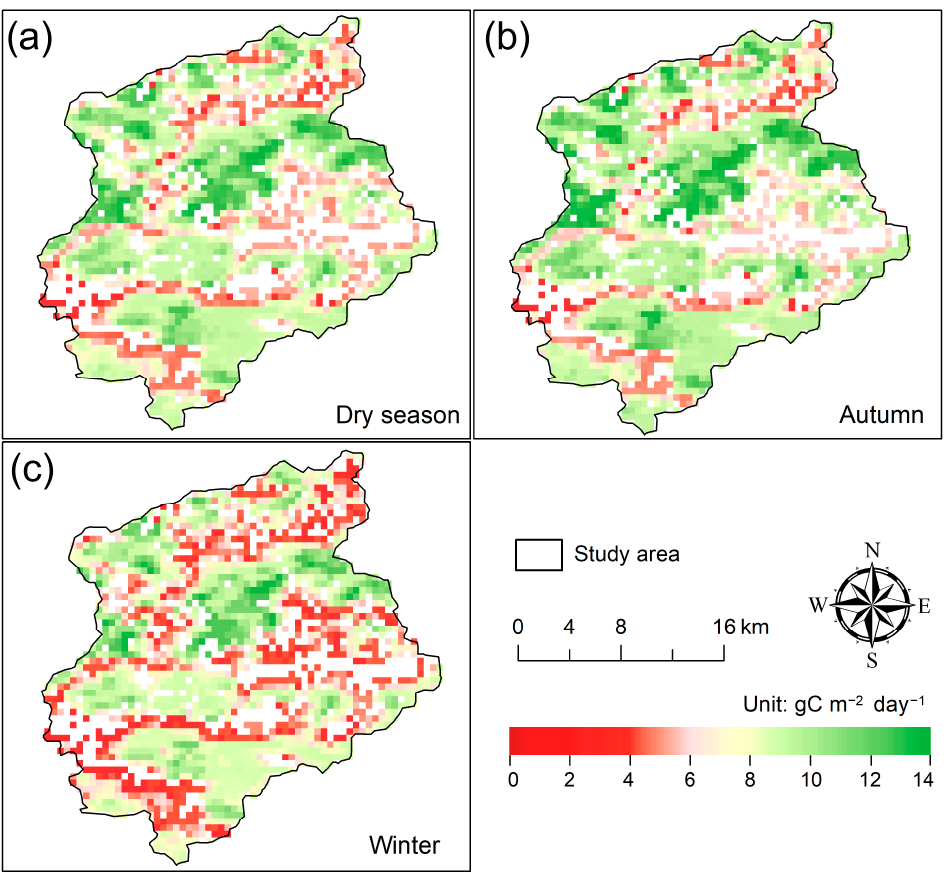
Figure 8. The average spatial patterns of FCO 2 in the whole dry season ( a ), autumn ( b ), and winter ( c ). The spatial distribution of the FCO 2 map is based on the mean values obtained from the two areas.